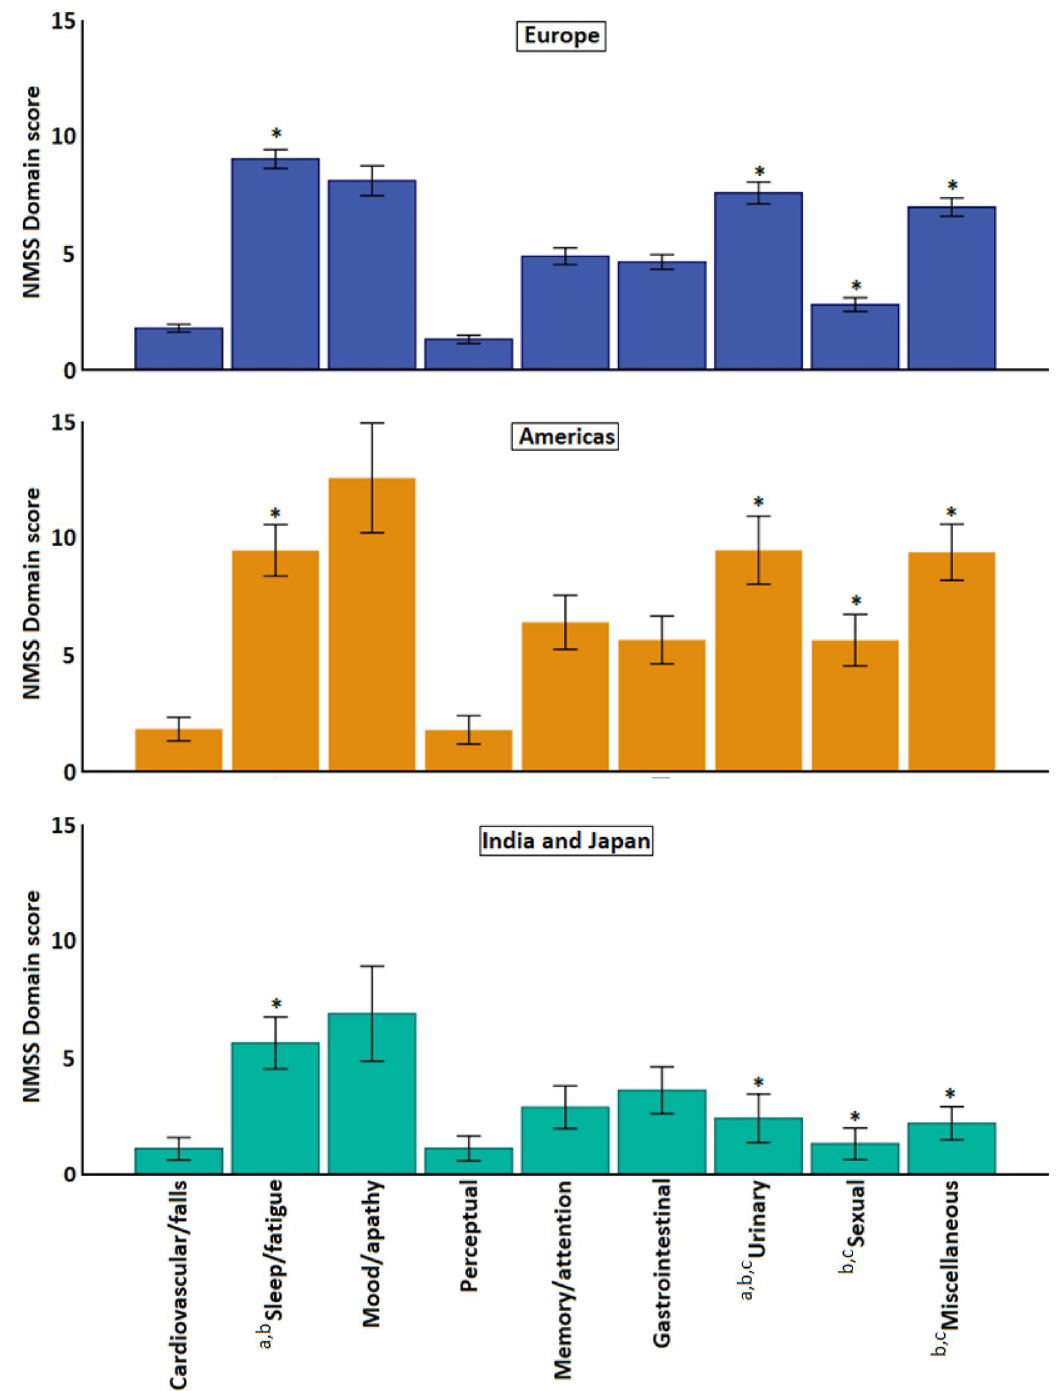
Figure 2. Distribution of specific non-motor domains of the Non Motor Symptoms Scale across different geographical regions in participants with Parkinson’s disease. Data presented as mean; bars represent the 95% confidence intervals; * significant (p < 0.05) group differences. Post-hoc analyses (corrected values using Benjamini–Hochberg procedure): (a) difference between Europe and Americas (p < 0.05); (b) difference between Europe and India/Japan (p < 0.05); (c) difference between Americas and India/Japan (p <